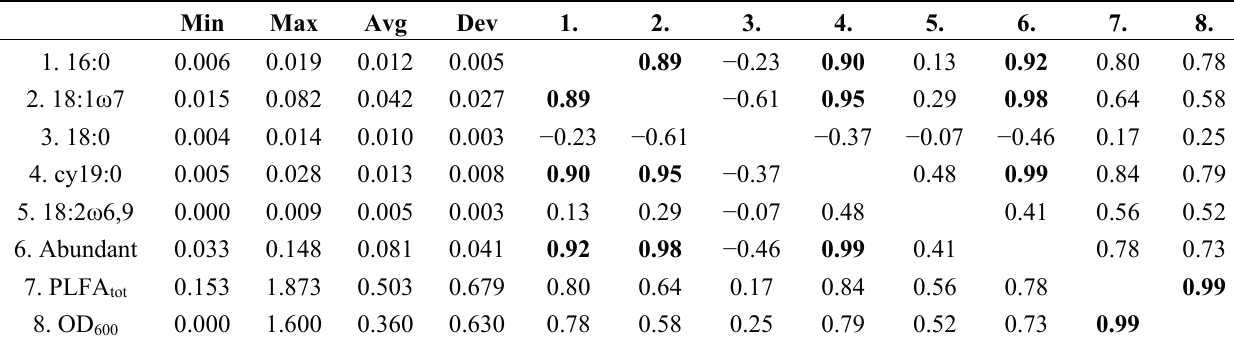
Table 2. Correlation between total PLFA, selected abundant FAME [mg.g − 1 dry gel] and input biomass of encapsulated P. denitrificans (gels A0 to A6); n = 12, correlations significant at α = 0.05 are typed red